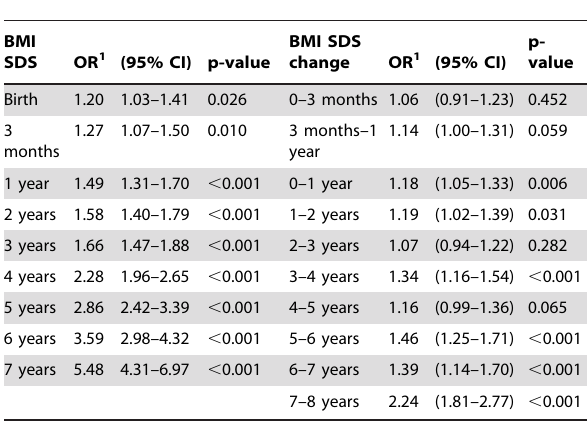
Table 6. Associations between BMI SDS and BMI SDS change from birth to 8 years of age and overweight at 8 years of age for girls